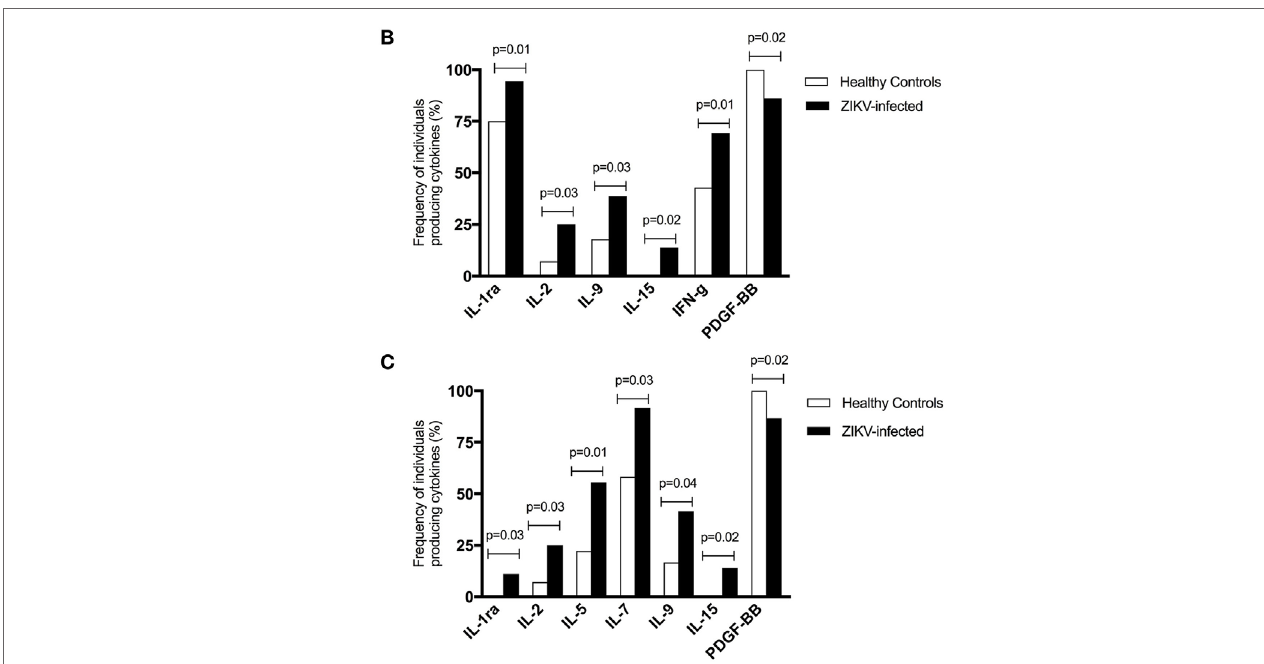
FigUre 2 | Plasma concentration and frequency of differentially expressed cytokines in acute Zika virus (ZIKV)­infected individuals compared to healthy controls. (a) Cytokines measured in the plasma of acute ZIKV­infected individuals and healthy controls and the concentrations of differentially expressed cytokines are shown. The dots on the graphs represent individuals. p ­Values are indicated at the top of each graph. The non­parametric Mann–Whitney test was used and considered significant when p < 0.05. The cytokine frequencies of ZIKV­infected individuals and healthy controls showed significant differences considering the limit of detection of the test (b) and based on the standard curve range (c) . Chi­square tests were used (b,c) and p < 0.05 was considered